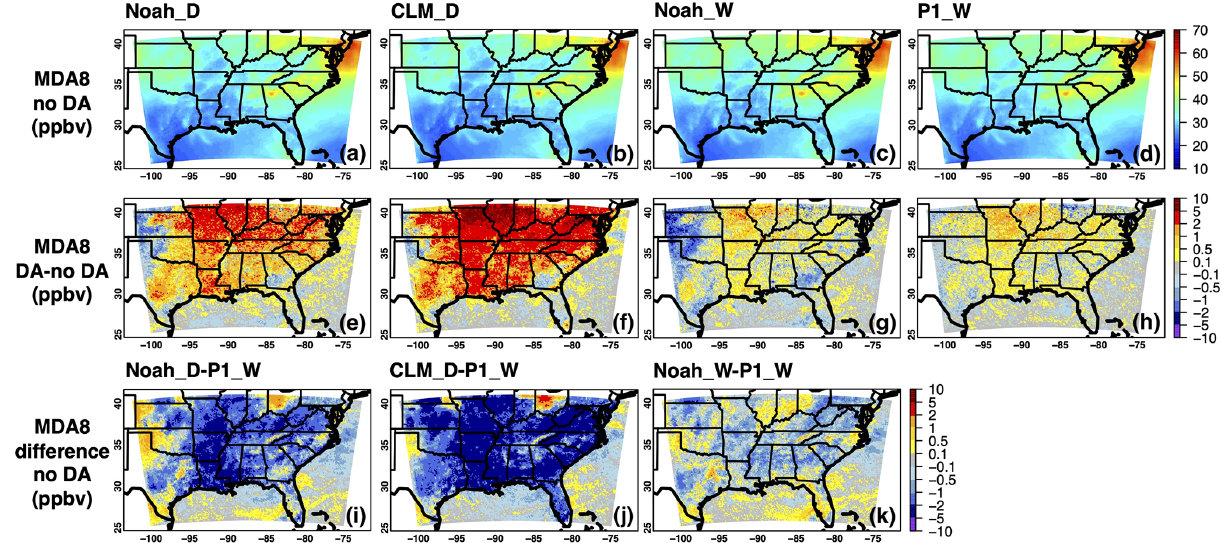
Figure 11. Period-mean (16–28 August 2016) WRF-Chem (a–d) surface MDA8 O 3 fields and (e–h) their responses to the SMAP DA. Results based on the Noah_D, CLM_D, Noah_W, and P1_W cases are shown in (a) and (e) , (b) and (f) , (c) and (g) , and (d) and (h) , respectively, and the differences between the Noah-MP-related cases and the P1_W case are shown in (i) – (k)